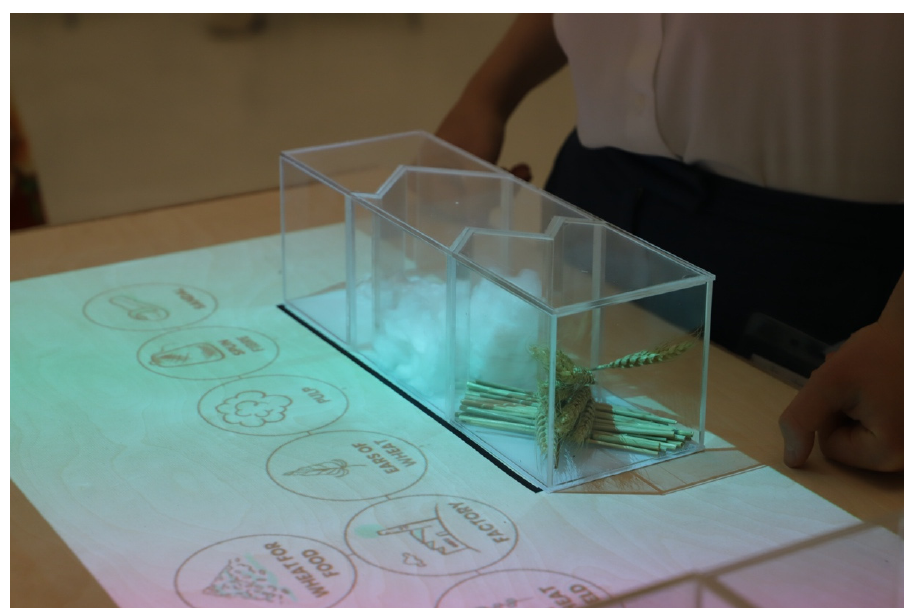
Figure 5. Material Stories.